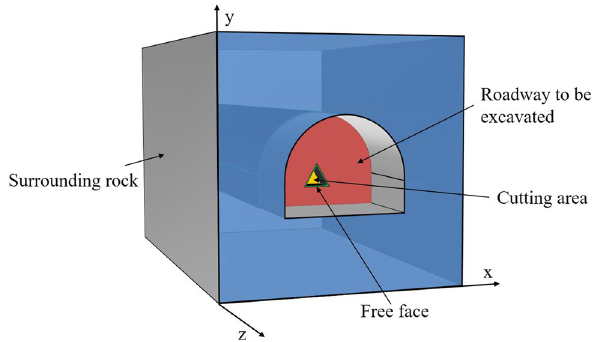
Fig. 4 Schematic diagram of cut blasting in coal mine